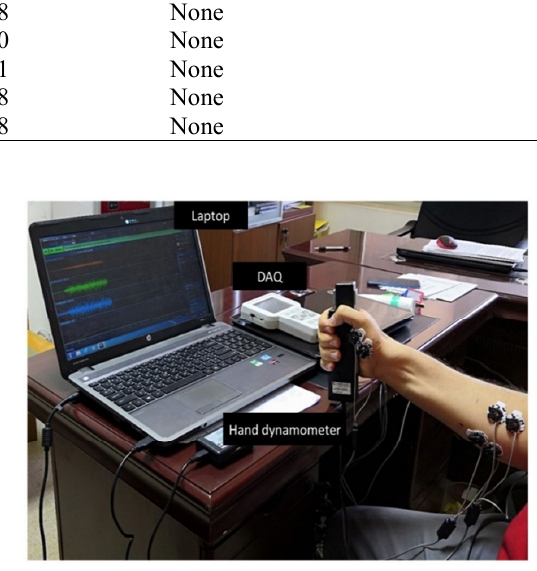
Fig. 2. EMG and hand grip force measurement experimental setup, computer laptop, data acquisition (DAQ) device with Myotrace 400, and Vernier hand